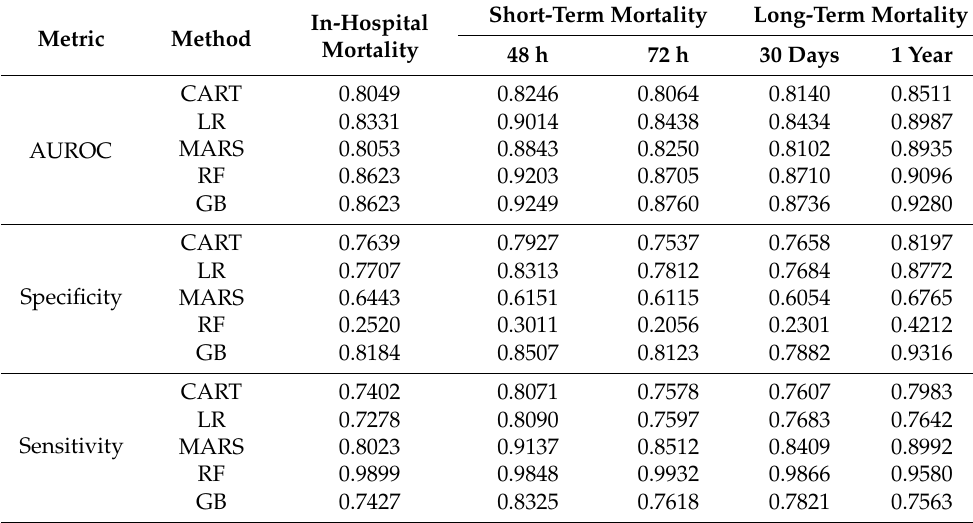
Table 7. Comparisons between different models constructed using 24 h dataset in terms of their prediction